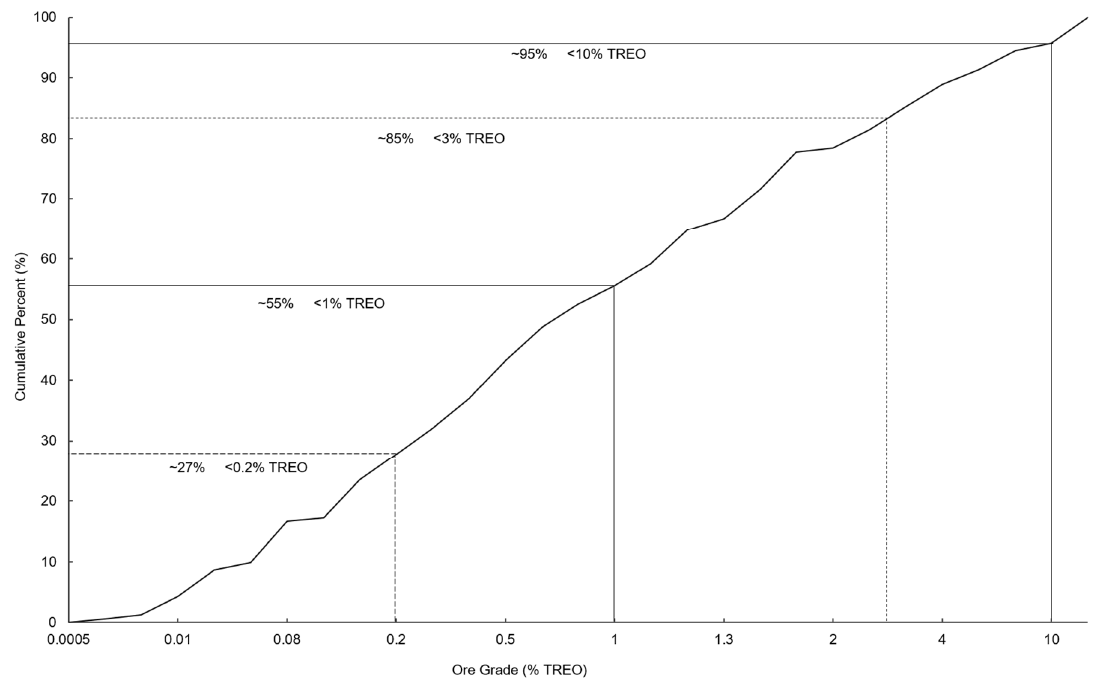
Figure 4. Cumulative frequency curves for the ore grade.